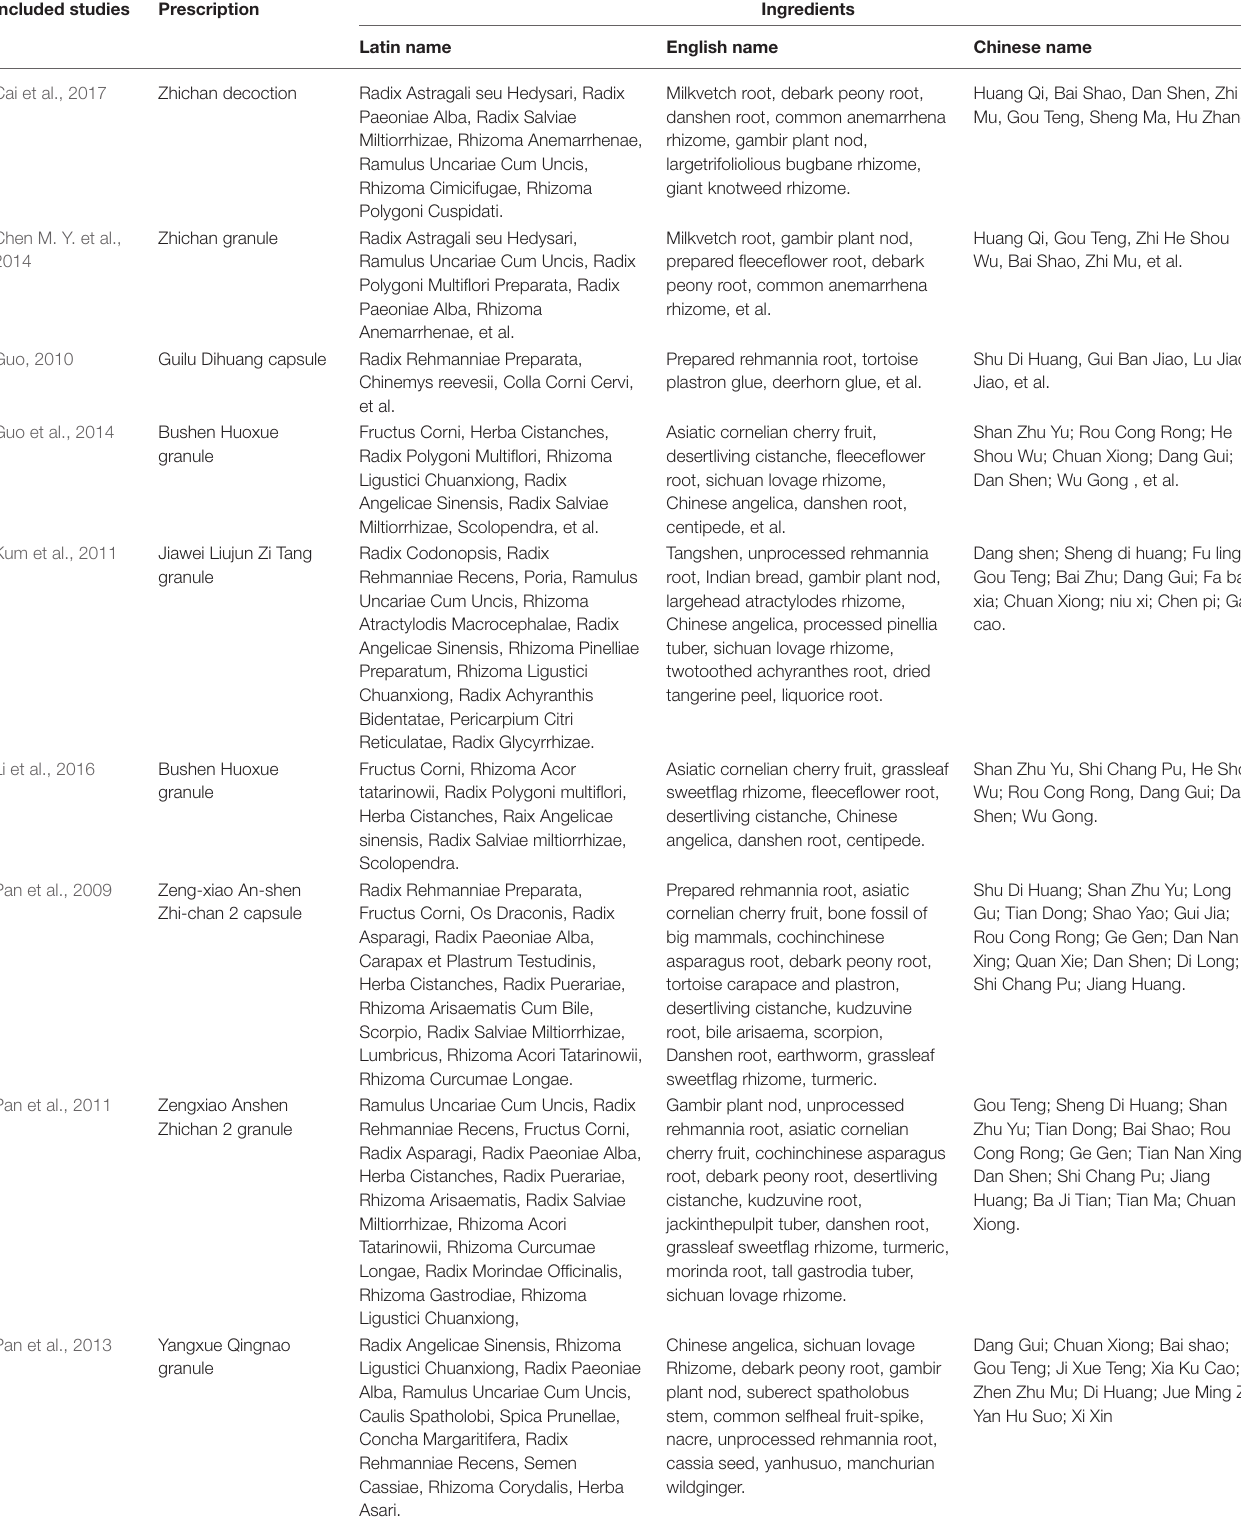
TABLE 2 | Ingredients of TCM